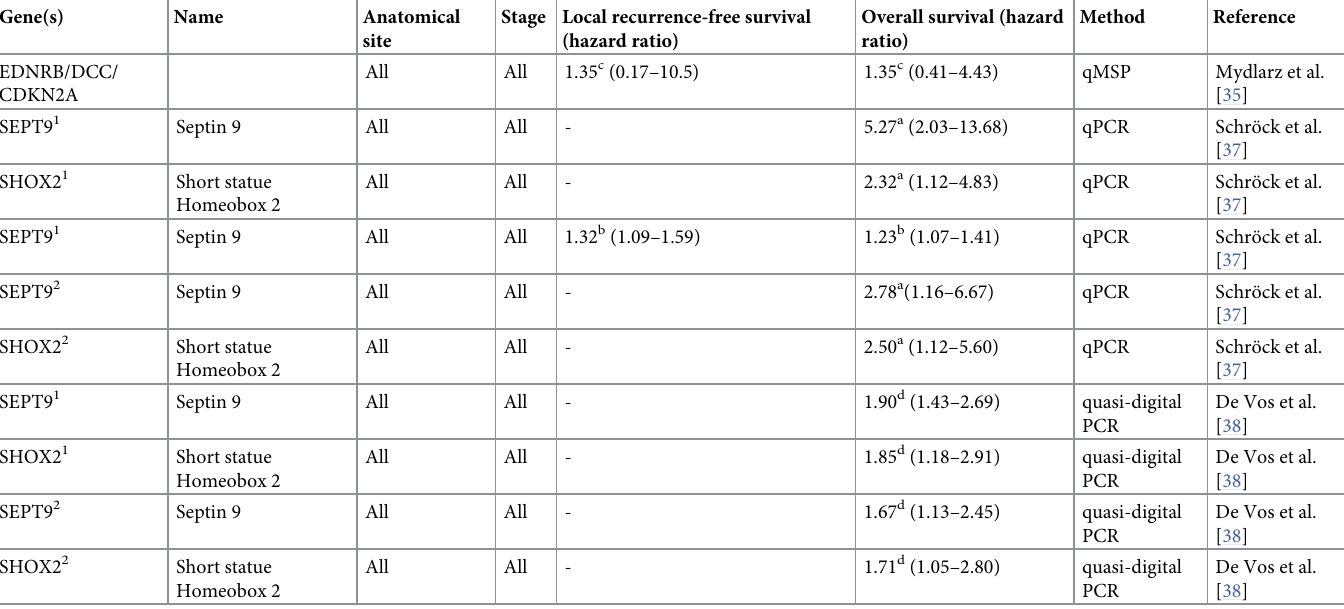
Table 2. Prognostic value of DNA methylation in plasma or